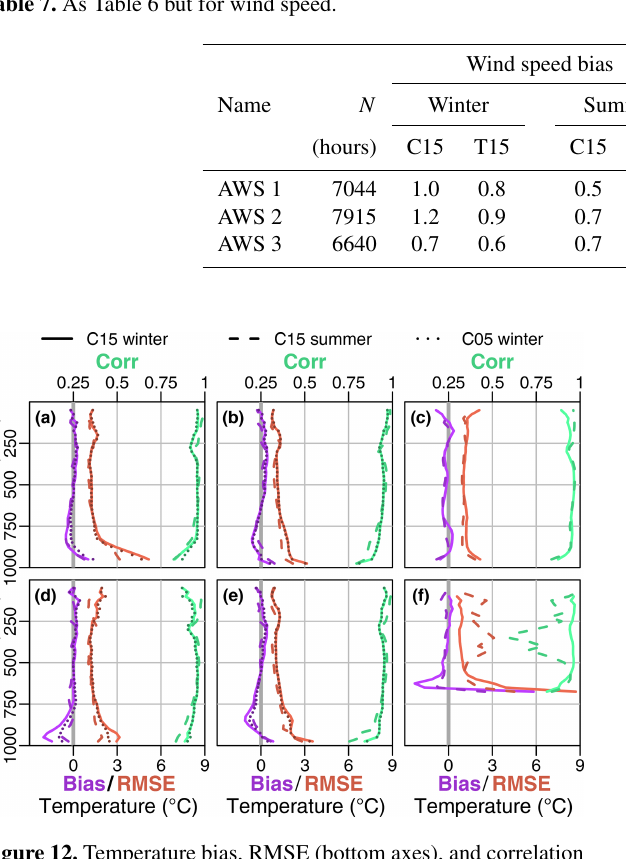
Figure 13. Like Fig. 12 but for wind speed. cal to C15. The bias is again almost 0 except near the sur- face. The RMSE for wind speed is around 3 to 4 ms − 1 and slightly lower during summer. Bias and RMSE are largest for Marambio (a) and Rothera (d) in the lowest 200 hPa, and as for the temperature C05 yields slight improvements for these stations. Souverijns et al. (2019) found a mean average error for wind speed of 2.1 to 3.6 ms − 1 for all seasons. The RMSE for wind direction is around 50 ◦ near the surface and reduces with height to 20 ◦ at 250 hPa, except for Amundsen–Scott (f) where it stays around 50 ◦